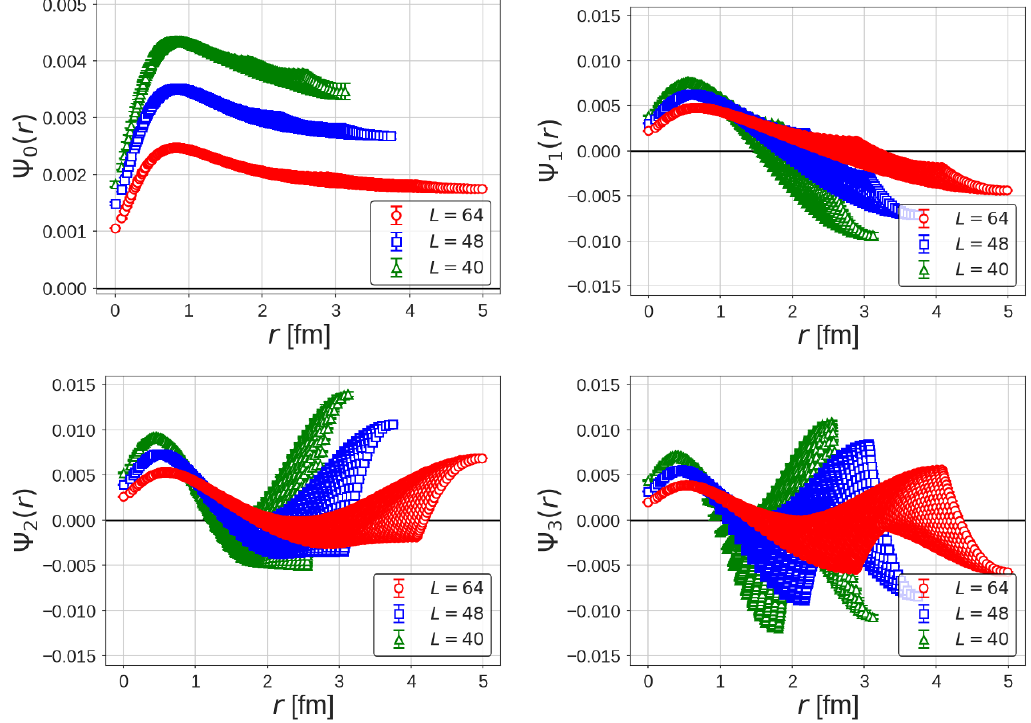
Figure 13 . The low-lying eigenfunctions (cid:9) n ( ~r ) in the A + representation of the HAL QCD Hamil- 1 tonian with V LO(wall) at t=a = 13 for L = 40 ; 48 and 64. The top-left, top-right, bottom-left, 0 bottom-right (cid:12)gure corresponds to n = 0 ; 1 ; 2 ; 3, respectively. The eigenfunction is normalized as P j (cid:9) n ( ~r ) j 2 = 1 and its sign is (cid:12)xed to satisfy (cid:9) n ( ~ 0) > ~r